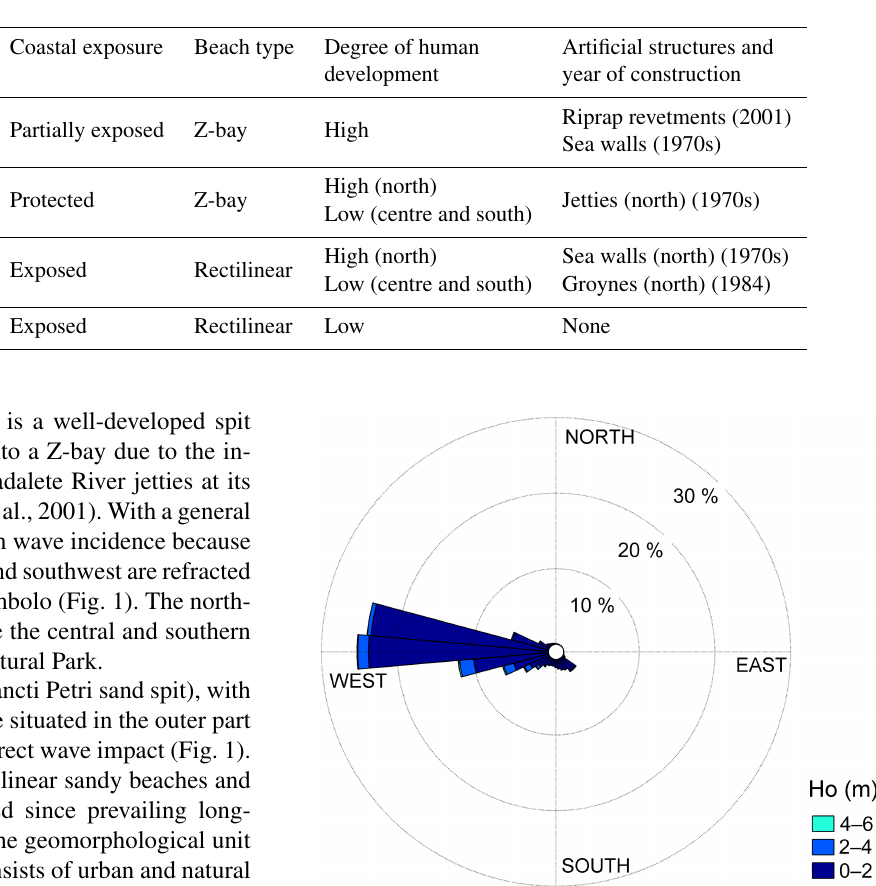
Table 1. Summary of the characteristics of each geomorphological unit.